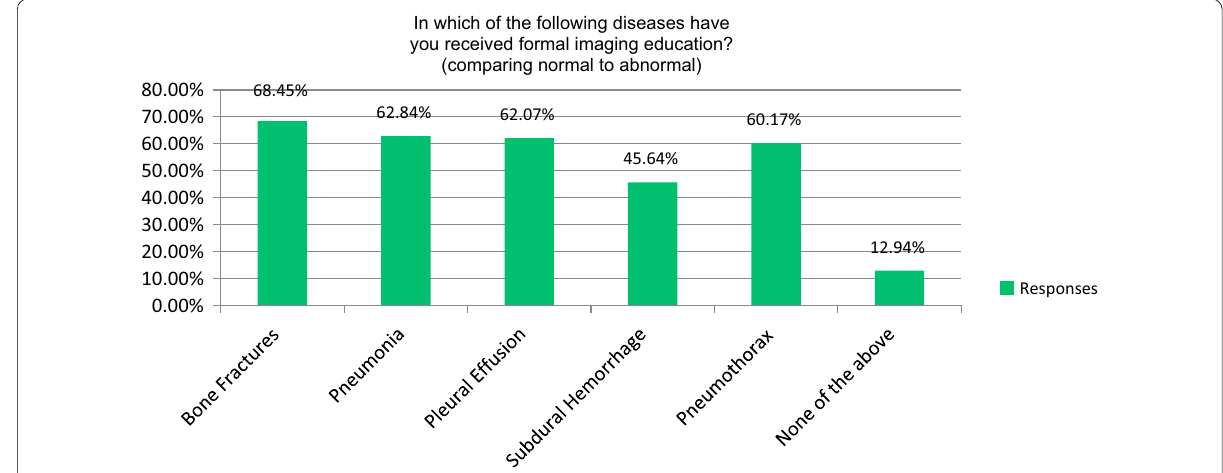
Fig. 3 Student’s responses to image interpretation on a 4-point Likert